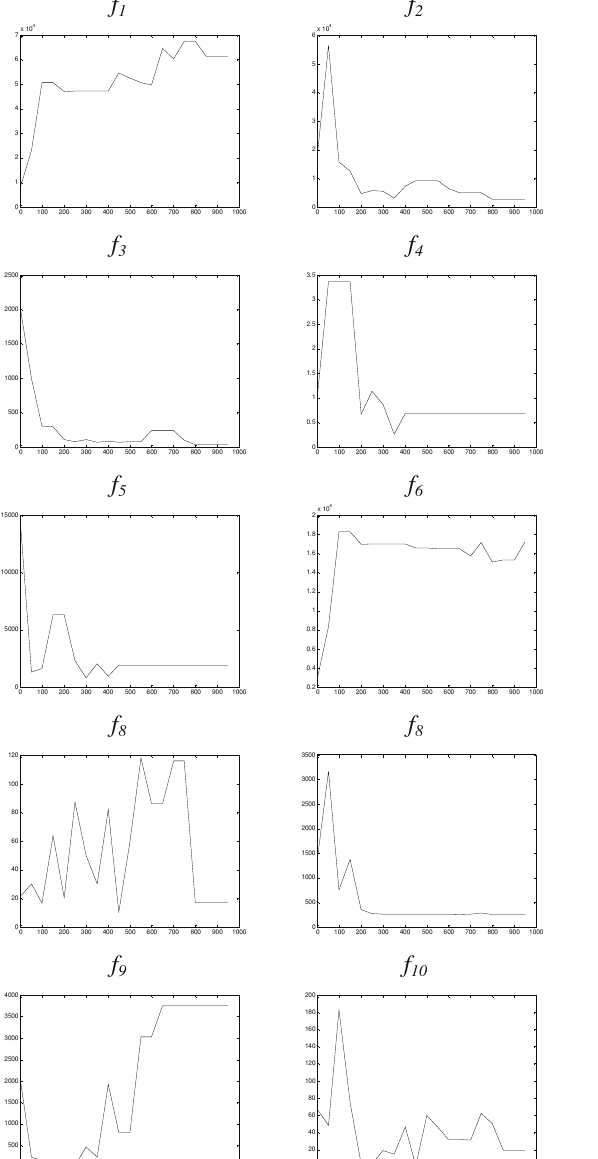
Fig 5. Frobinous norm of the weights of the normal RBFNN used in the normative knowledge source of the proposed